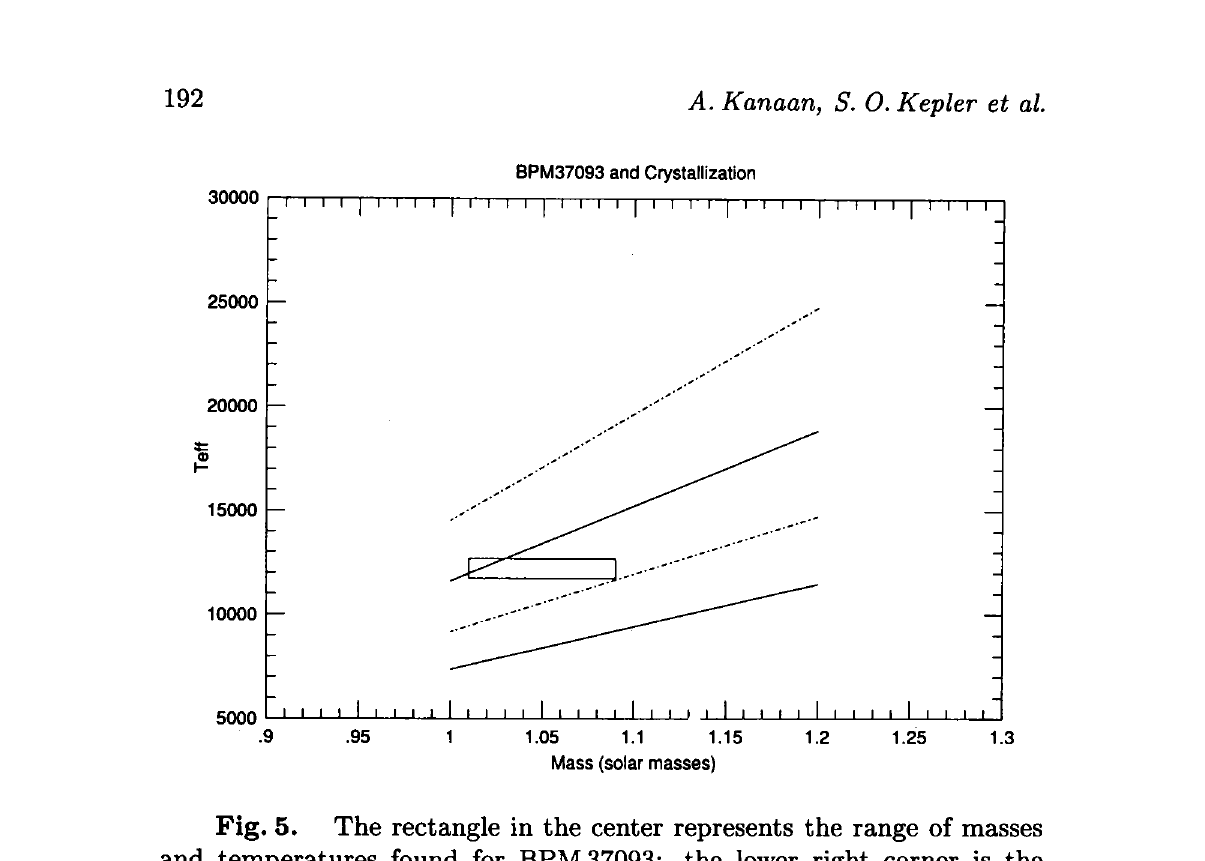
Fig. 5. The rectangle in the center represents the range of masses and temperatures found for BPM 37093: the lower right corner is the determination of Bergeron et al. (1995), the top left corner is the determi- nation of Giovannini (1996). The formal temperature uncertainties from each author are much less than their discrepancies. The lines represent the limits where crystallization reaches 10 % (top line) and 90 % (bottom line). The continuous line is for an oxygen core, and the long-short dash line is for a pure carbon core. core is pure oxygen. For heavier compositions, the core should be entirely